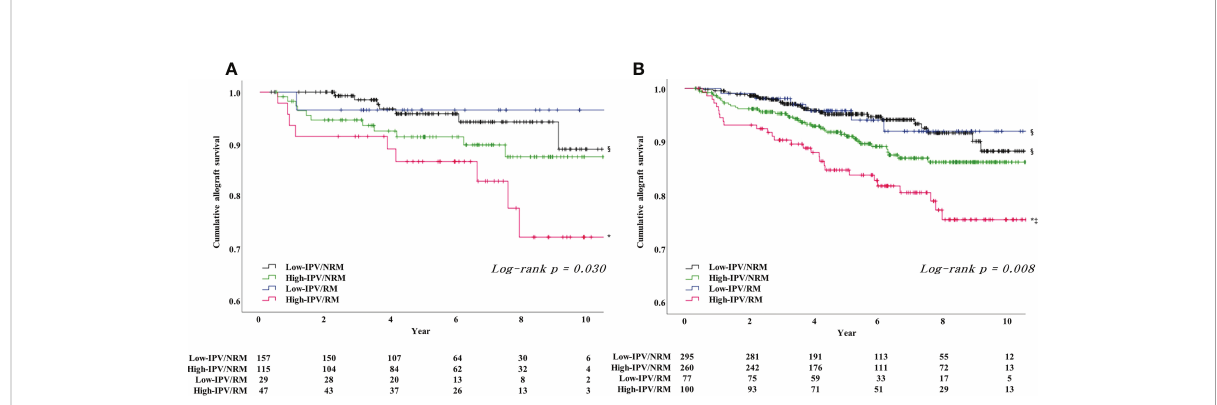
FIGURE 4 Result of Kaplan – Meier survival analysis for allograft survival for each PRA-positive and -negative subgroups based on TAC-IPV and RM/NRM status. (A) Allograft survival in the PRA-positive subgroup was the lowest in the high-IPV/RM group, and the allograft survival rate was remarkably reduced compared to the rates of the overall cohort and PRA-negative subgroup. (B) Allograft survival in the PRA negative subgroup was the lowest in the high-IPV/RM group, and the allograft survival rate was comparable with those of the overall cohort. *Log-rank P <0.05 versus low-IPV/NRM group; ‡ log-rank P <0.05 versus low-IPV/RM group; § log-rank P <0.05 versus high-IPV/RM group.